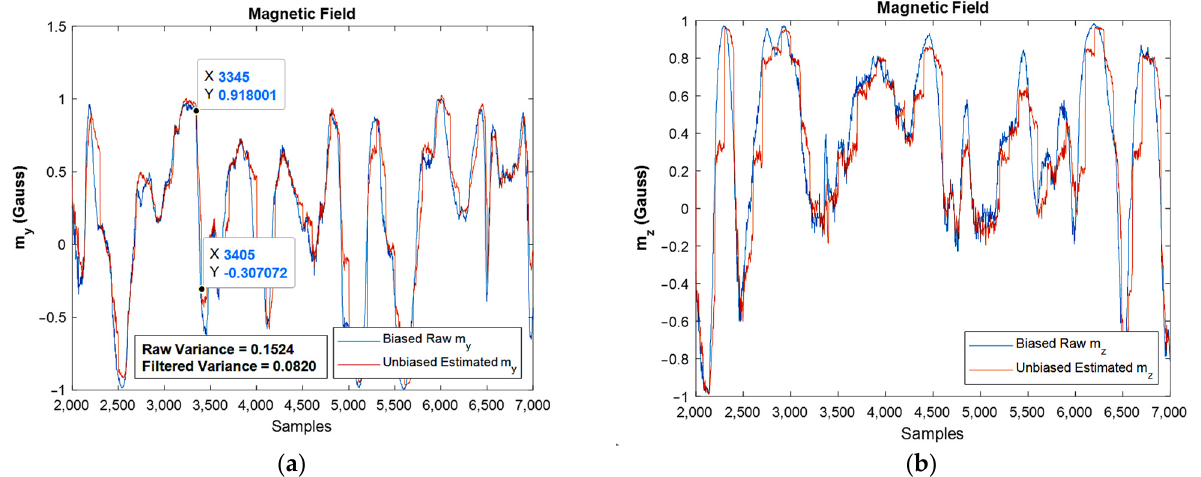
Figure 16. The estimated magnetic field for moving IMU in y and z directions against raw ones: ( a , b ), respectively.